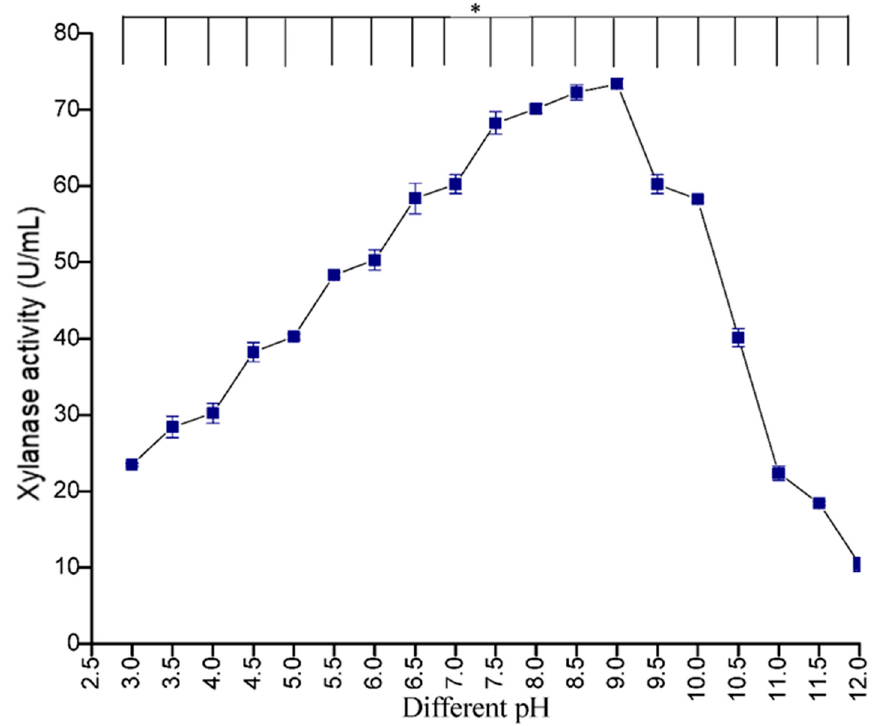
Figure 7. Effect of pH on xylanase production by B. safensis XPS7 (Medium: M5; temp.: 30 °C; time: 24 h; pH: 2.5 to 12; inoculum: 4%). All the experiments were performed in triplicate. Line graph display mean ± SD and statistical analysis was performed using a one-way ANOVA with a Tukey post hoc test, with p < 0.01 *.